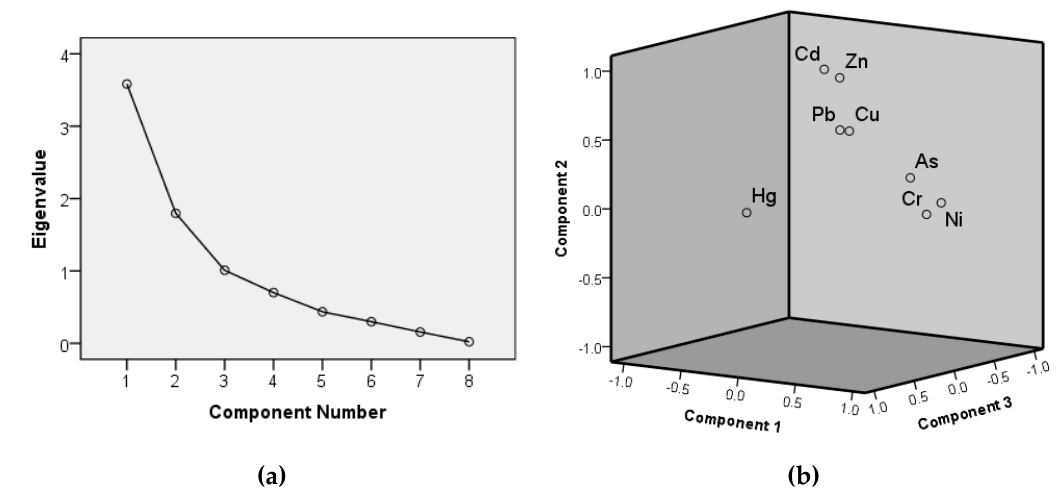
Figure 4. The scree plot ( a ) and three component plots in the matrix ( b ).